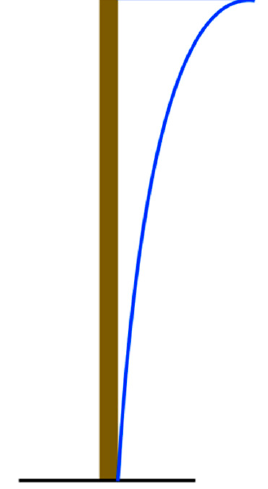
Figure A11. The 6 × 6 Bending Moment Diagram. The maximum bending moment occurs at the footing, and can be calculated using Equation (A13). where x is the distance from the footing to each of the 2 × 4 reactions. The deflection diagram is shown as in Figure A12.